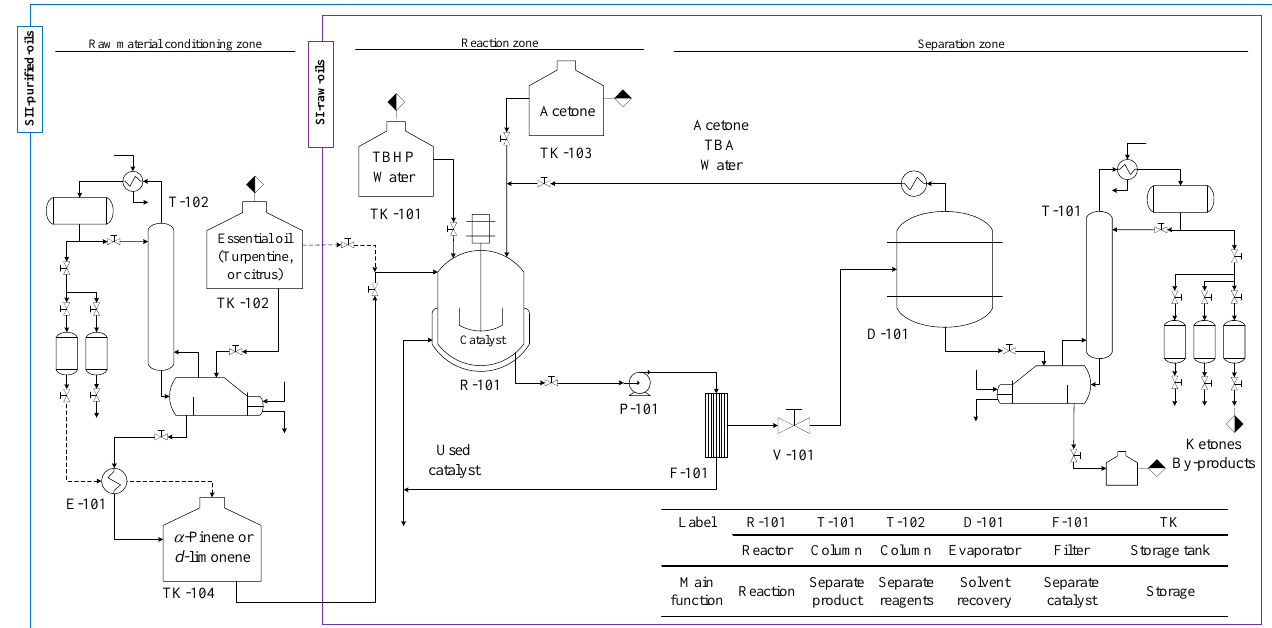
Figure 2. Process flow diagram for two scenarios (SI-raw-oils and SII-purified-oils) in the batch production of verbenone and carvone from turpentine and orange oils oxidation with TBHP and FePcCl 16 -NH 2 -SiO 2 . Table 1. Design parameters of the proposed scenarios in the conceptual process for the production of verbenone and carvone.